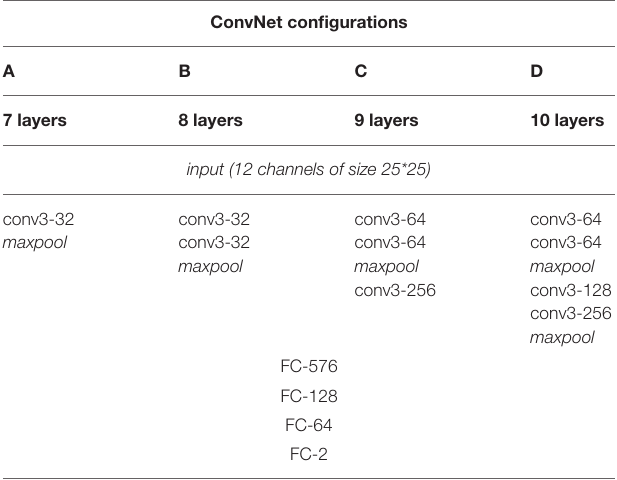
TABLE 1 | Different configurations of Wind CNN